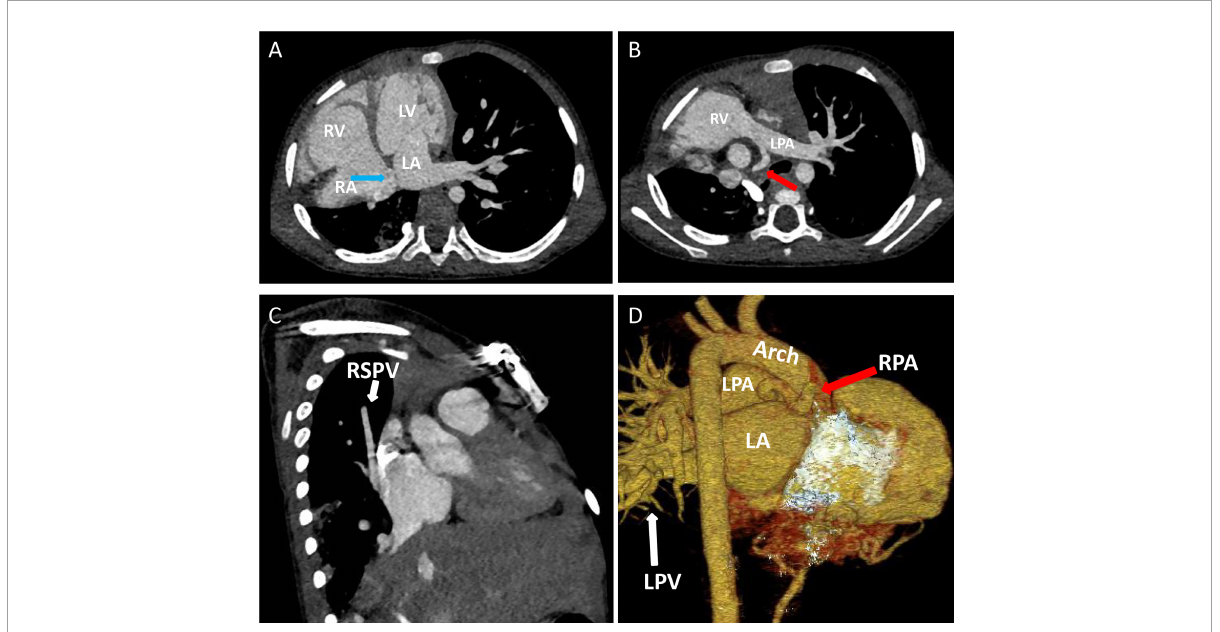
FIGURE1 Contrast-enhanced CT of the chest and three-dimensional cardiac computed tomography angiography: (A) Atrial septal defect location, ∼ 9 mm in size (blue arrow). (B–D) The right pulmonary artery (red arrow) and right superior pulmonary vein are hypoplastic (white arrow). LA, left atrium; LPA, left pulmonary artery; LPV, left pulmonary vein; LV, left ventricle; RA, right atrium; RPA, right pulmonary artery; RSPV, right superior pulmonary vein; RV, right ventricle.